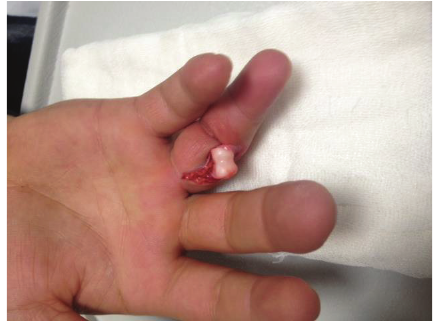
Figure 2: Injury showing open finger dislocation.